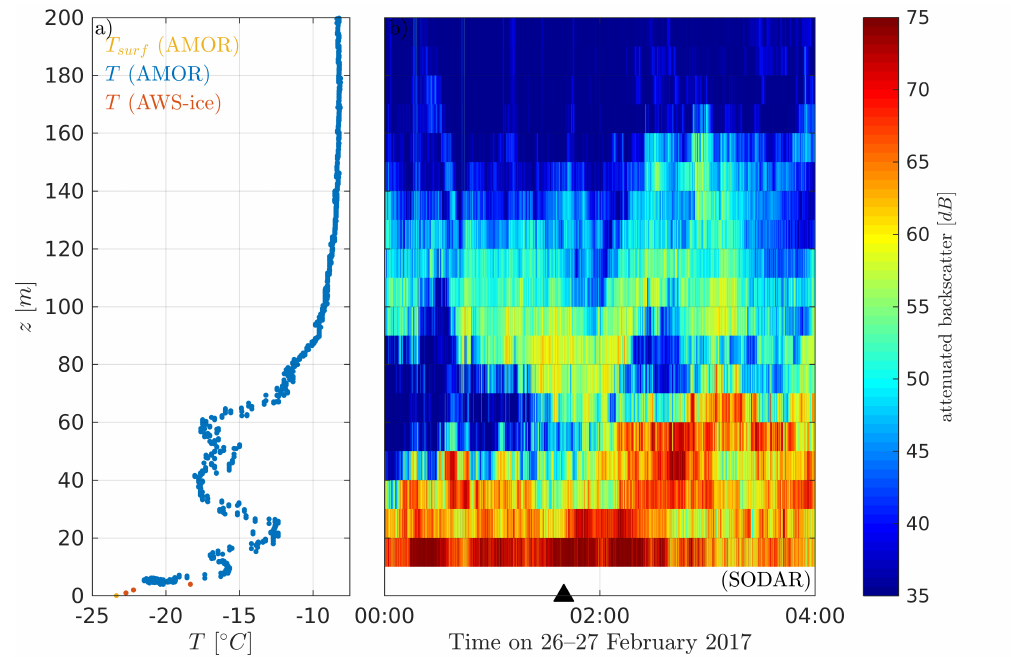
Figure 12. The structure of the ABL during 26 to 27 February: ( a ) vertical temperature profile taken by an AMOR multicopter (blue dots) and compared to the Automatic Weather Station (AWS-ice, red circles) from 1:40 UTC to 1:43 UTC, and ( b ) attenuated backscatter from the LATAN-3M SODAR between 0:00 UTC and 4:00 UTC. The black triangle marks the start time of the AMOR